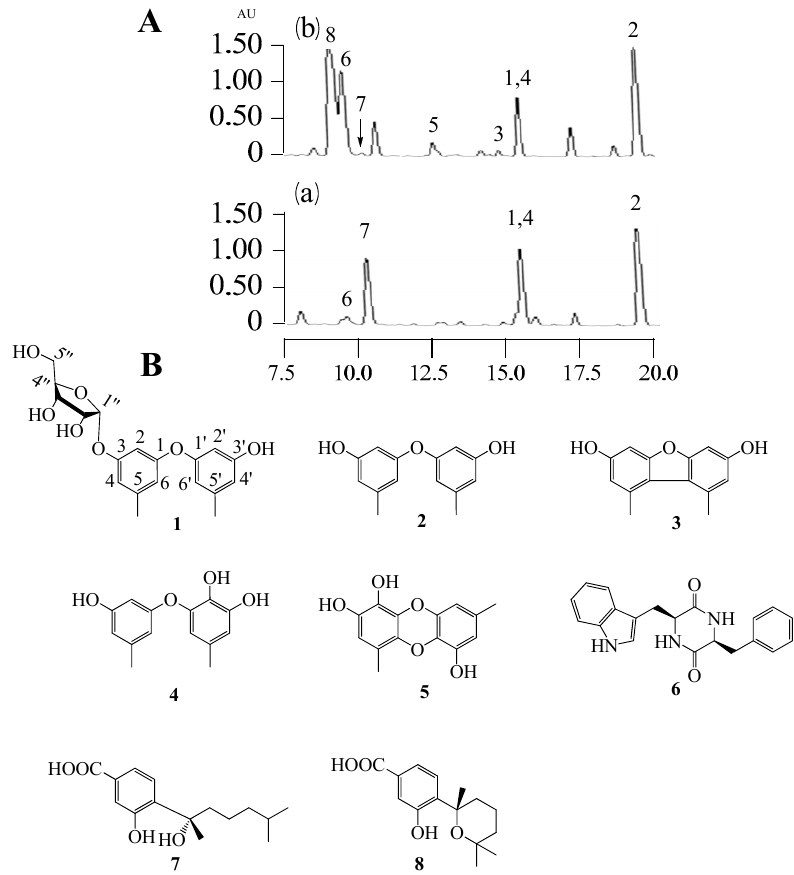
Figure 1. The secondary metabolite profile of Aspergillus sp. SCSIOW3 upon treatment with SBHA and 5-Aza. ( A ) HPLC-UV chromatogram at 254 nm of EtOAc extracts of untreated ( a ) and SBHA 1 mM + 5-Aza 1 mM treated ( b ) fermentation broth; ( B ) Structures of the identified substances 1 – 8 .